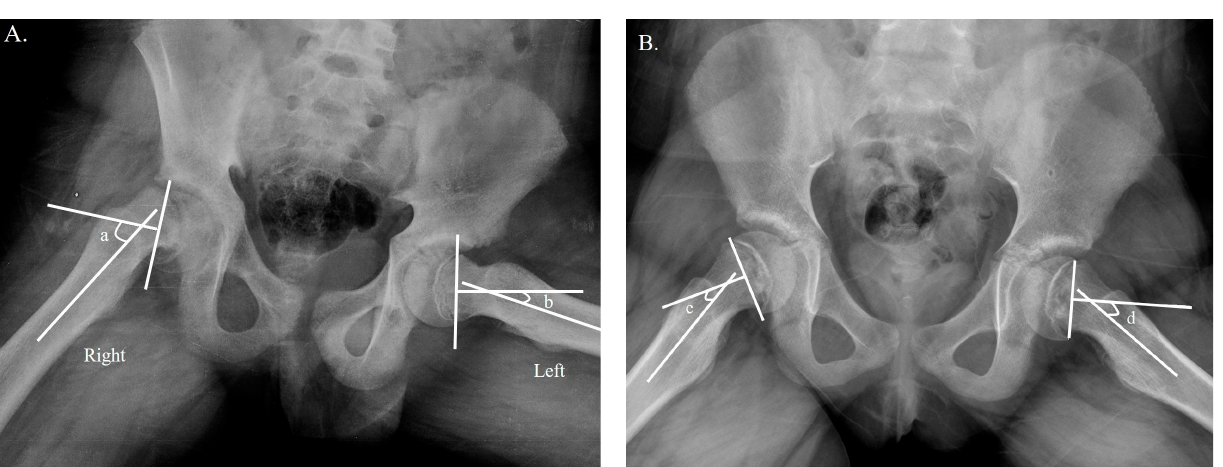
Table 1. Overall patient demographic